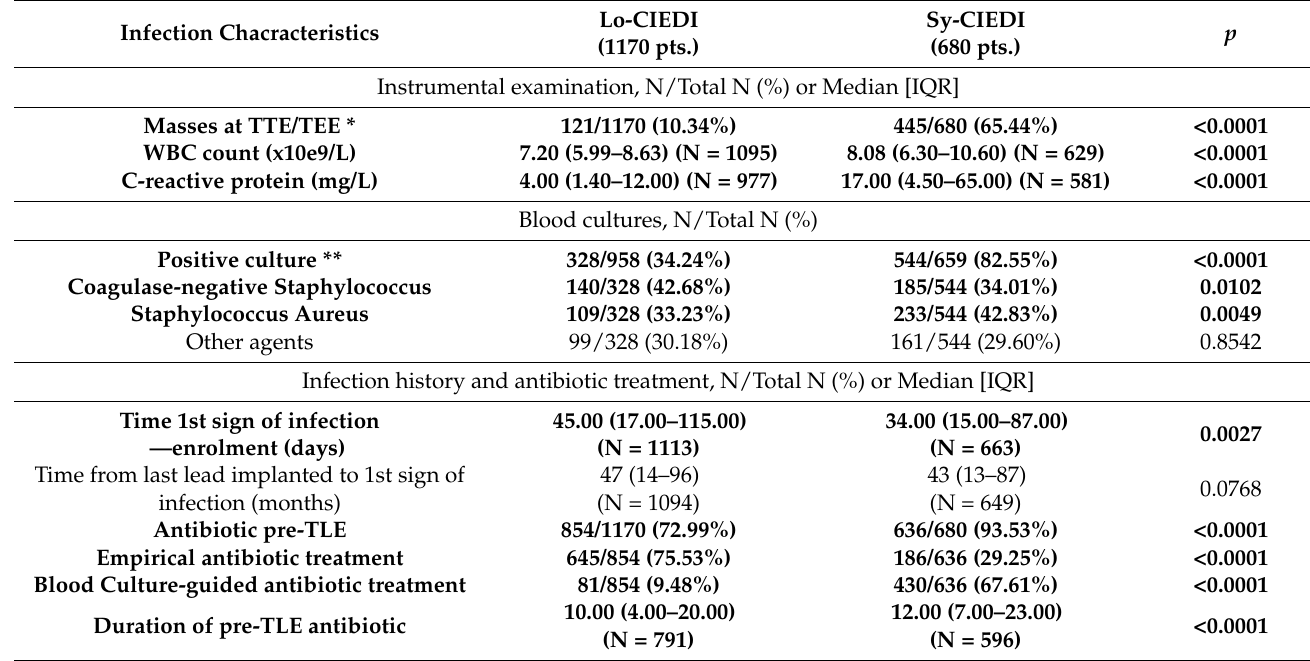
Table 3. Clinical and instrumental data on CIED infection in patients with Lo-CIEDI vs. Sy-CIEDI.